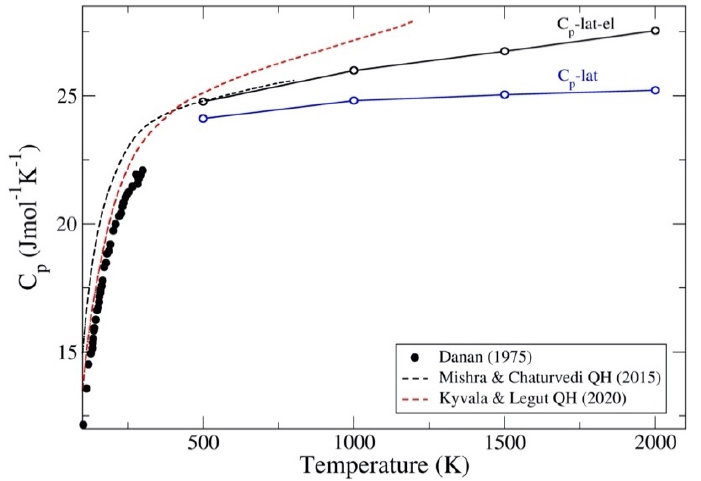
Figure 2. Specific heat at constant pressure, C p , for ThC. Levels of theory are open circles, where the connecting line is a guide for the eye only. The dashed lines refer to quasi-harmonic (QH) modeling [3,5]. Solid symbols are from experiment [54].